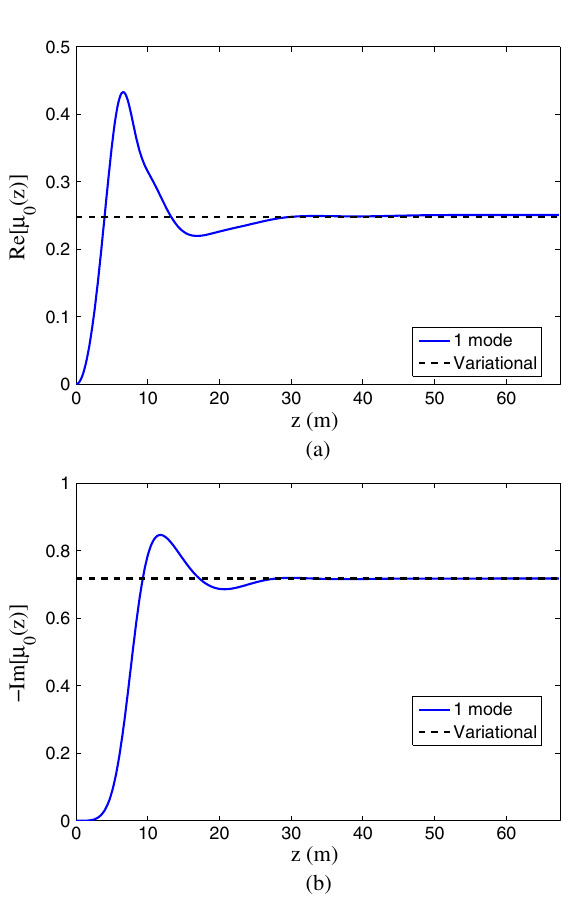
FIG. 2. (a) Real and (b) negative imaginary parts of the scaled, ð z Þ ¼ (cid:17) ð z Þ = ð 2 (cid:13) Þ (blue curves, based on k local growth rate (cid:17) m u 0 1-mode data). The dashed lines are the variational estimates for the fundamental FEL growth rate.